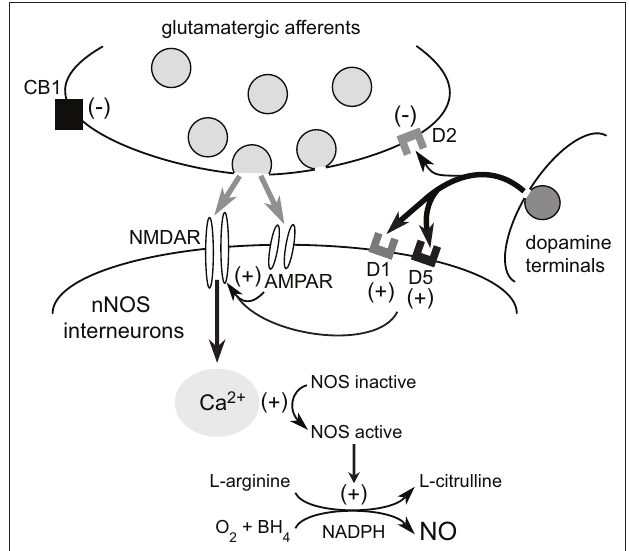
Figure 2 | glutamatergic modulation of striatal NOS interneurons by cortical inputs. Corticostriatal activation exerts direct excitatory effects on NOS interneurons via AMPA and NMDA receptor activation. NMDA receptor-dependent calcium influx activates nNOS and facilitates the conversion of l -arginine into l -citrulline and NO production. Dopamine release from the nigrostriatal pathway facilitates nNOS activity via D1/5 receptor stimulation. Furthermore, striatal NMDA receptor activation plays a critical role in the facilitatory effects of D1/5 receptor activation on striatal NO synthesis. Given that D1/5 receptor tone is also necessary for NMDA receptor activation of NOS, it is likely that reciprocal DA and glutamate interactions are crucial for the activation of striatal nNOS and